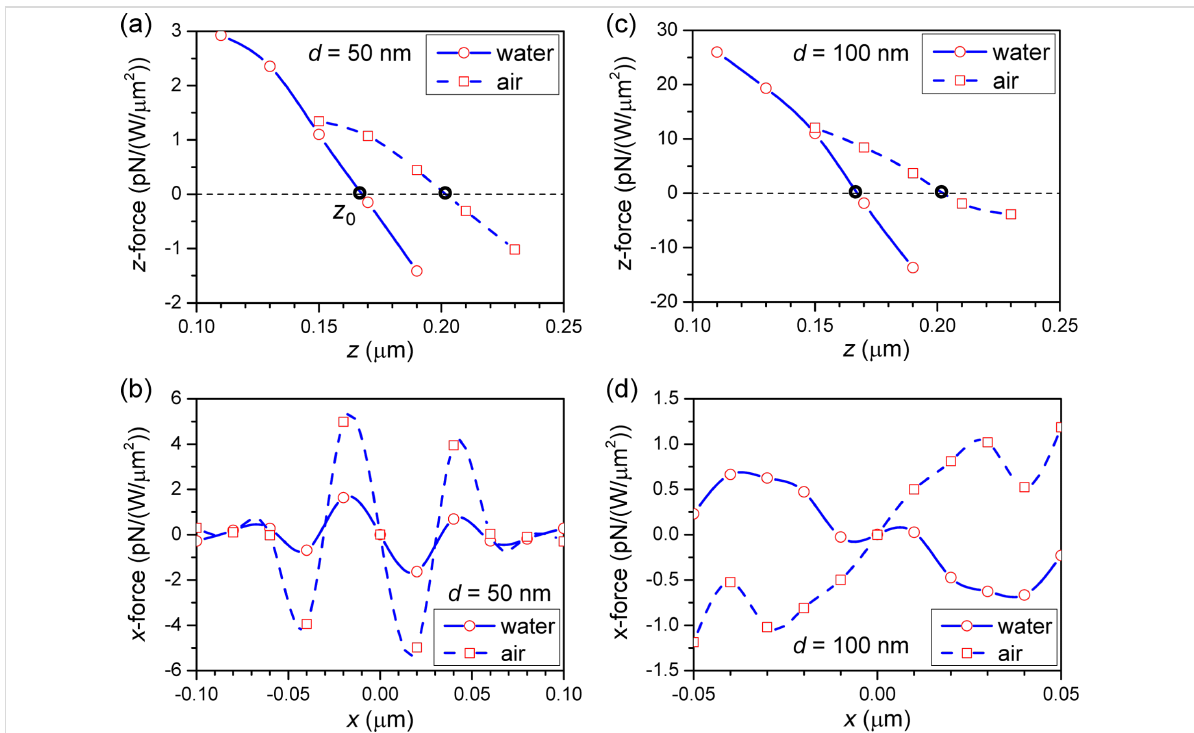
Figure 7: Force evaluation in the neighborhood of the central trapping spot (0, z 0 ) at 760 nm wavelength for a bead of diameter d in water (solid) and air (dashed): (a,c) f z ( z ) at x = 0 and (b,d) f x ( x ) at z = z 0 . The calculated values are indicated by the red markers, the blue lines are guides to the eye.